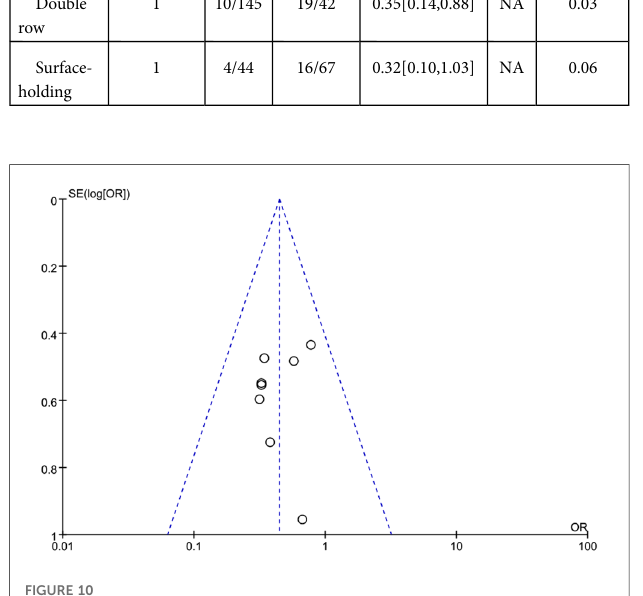
FIGURE 10 Funnel plot of data on re-tear